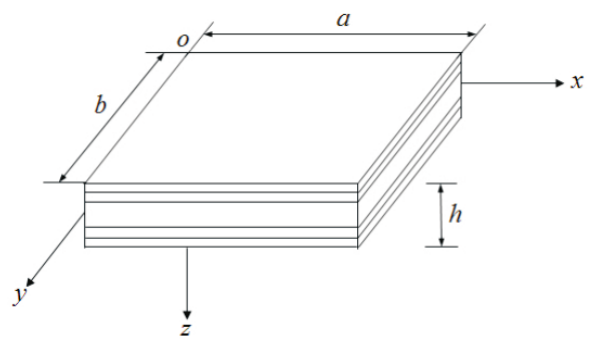
Figure 1: Plate geometry and coordinate